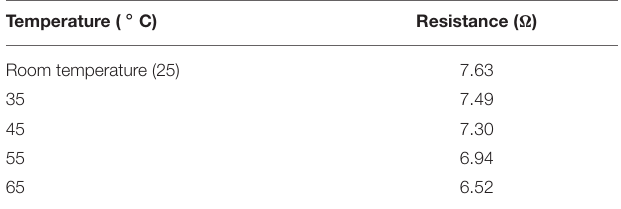
TABLE 5 | Values of resistance at different